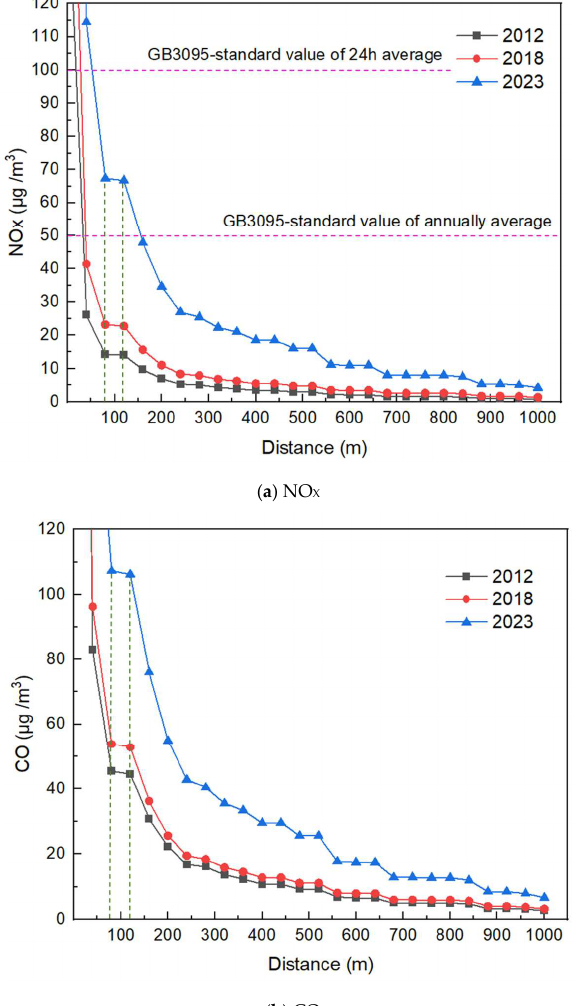
Figure 9. Annual average concentrations of NO X and CO vary with the distance in the Hengchengzi No. 2 Tunnel section.